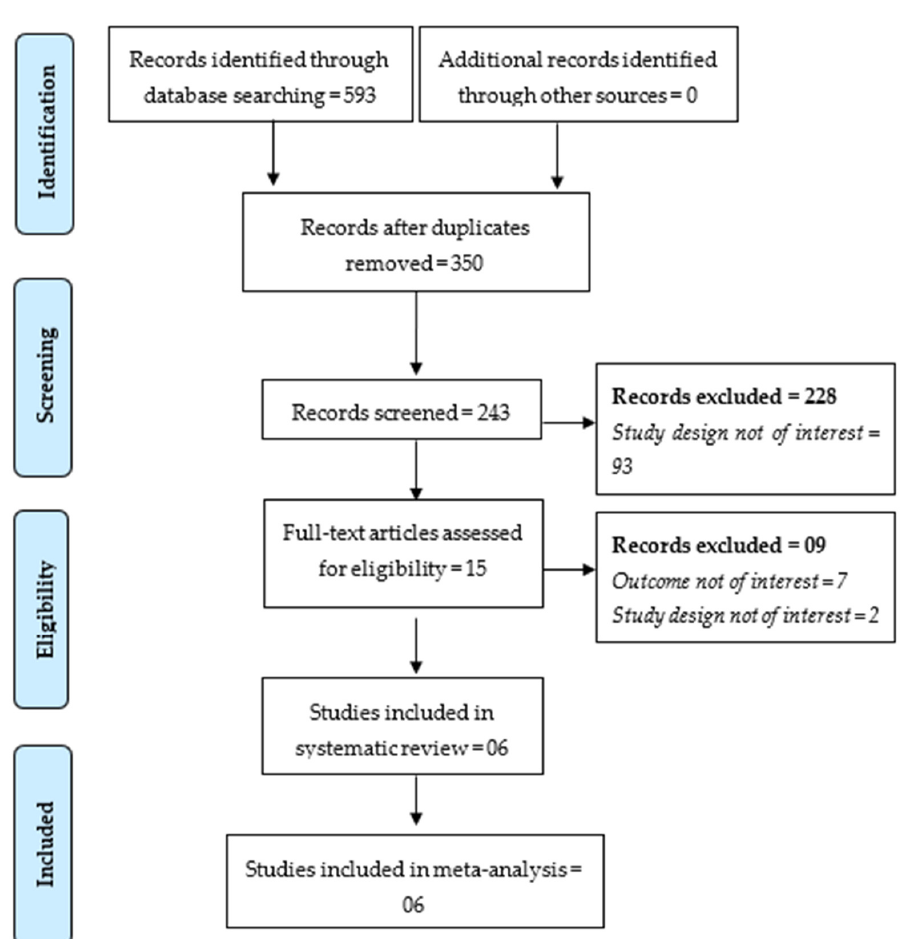
Figure 1. PRISMA Flowchart Displaying the Study Selection Process.